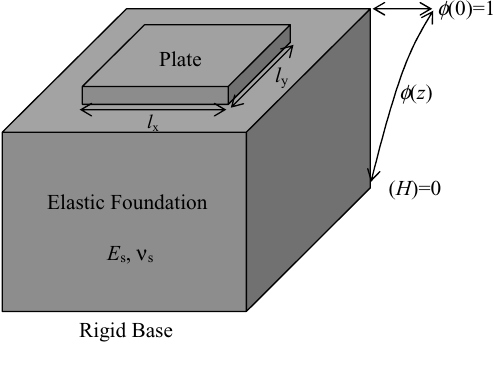
Fig. 1. A plate on elastic